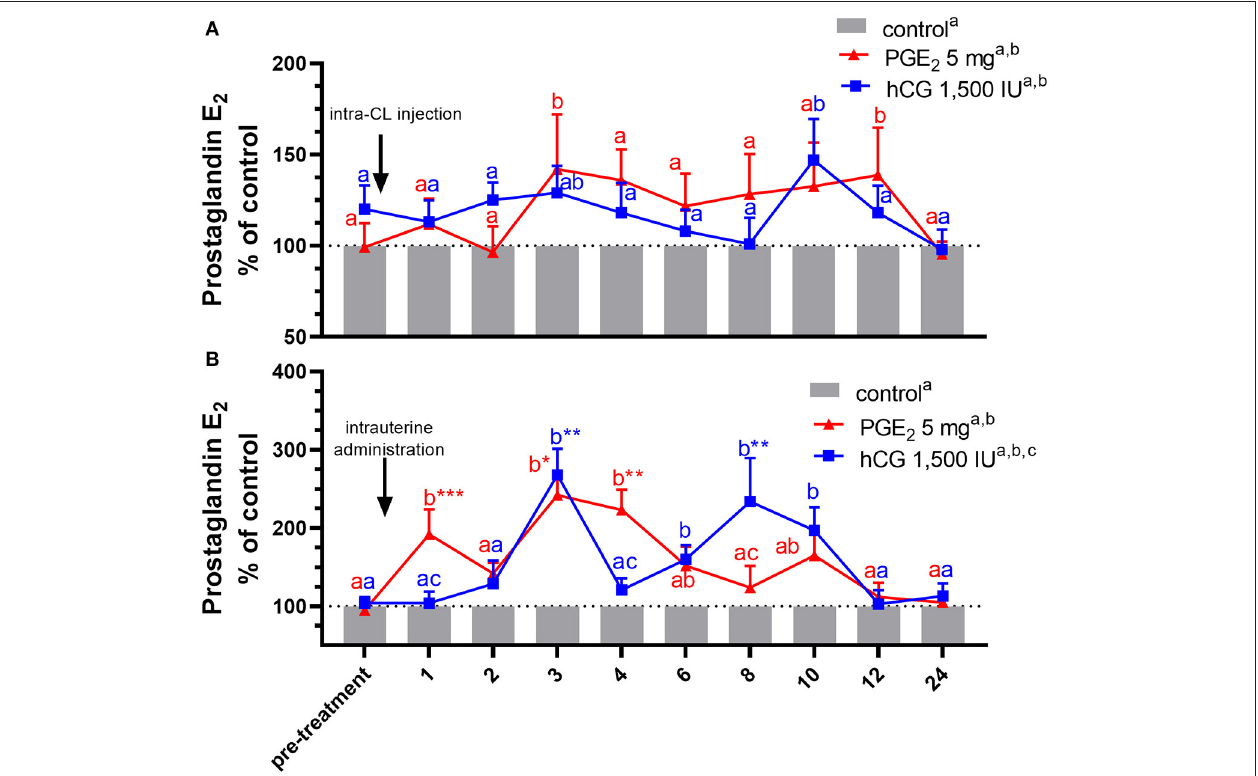
FIGURE 4 | Concentrations of prostaglandin (PG) E 2 in the jugular vein blood plasma in mares with one (A) intra-CL injection of saline (control; gray bar), PGE 2 (5 mg/ml; red line), or human chorionic gonadotropin (hCG, positive control; 1,500 IU/ml, blue line) or (B) one intrauterine administration of saline (control; gray bar), PGE 2 (5 mg/5ml; red line), or hCG (positive control; 1,500 IU/5ml, blue line) on day 10 of the estrous cycle. All values are presented as % of the control. Different superscript letters a,b,c indicate significant differences between blood PGE 2 level in PGE 2 - or hCG-treated groups of mares vs. control group at specific time points of blood sample collection. Asterisks indicate significant differences in blood PGE 2 level within PGE 2 - or hCG-treated group of mares vs. average concentration of PGE 2 in the period before treatment (pre-treatment time: − 2 to 0h). Average concentrations of PGE 2 in the blood plasma samples of control mares during the period before treatment (pre-treatment time) were (A) 243.39ng/ml or (B) 264.18, respectively. The results were considered significantly different at p < 0.05.